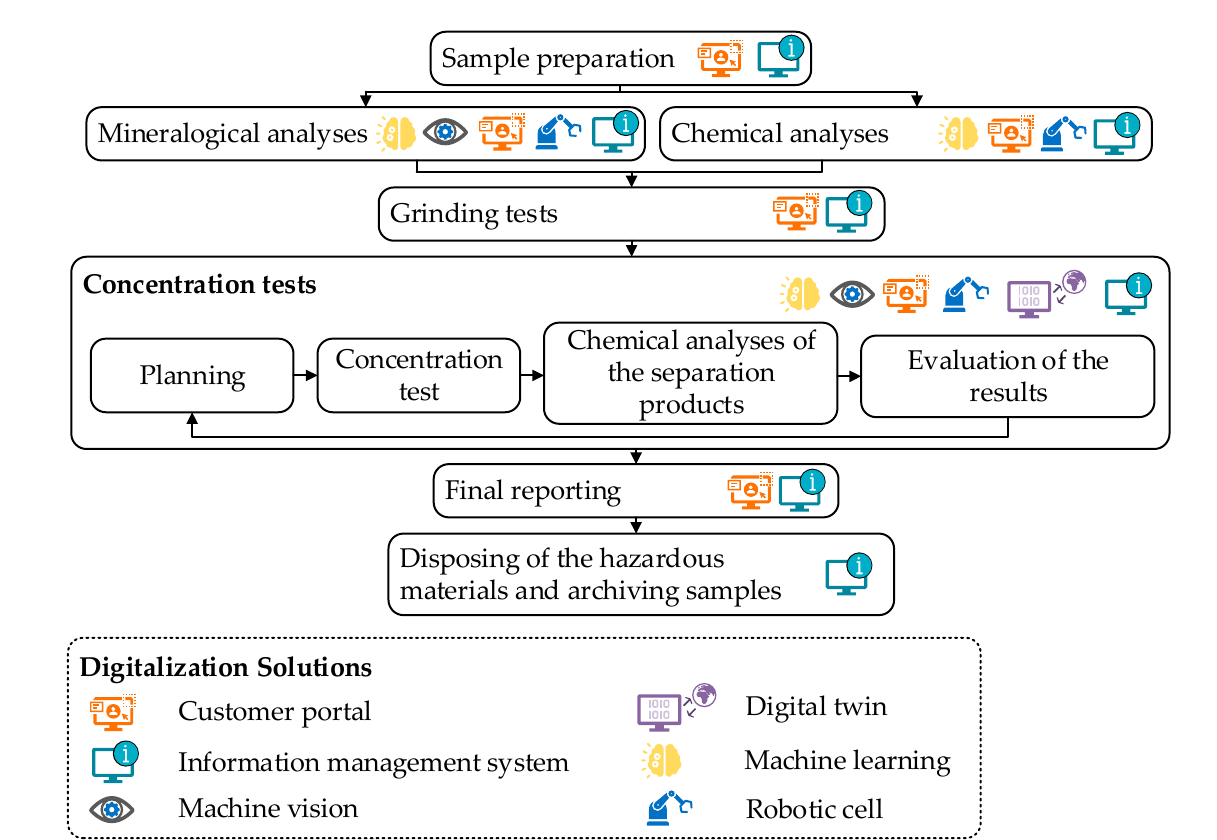
Figure 4. Flowchart of the general steps of a bench-scale project and corresponding digitalization solutions.